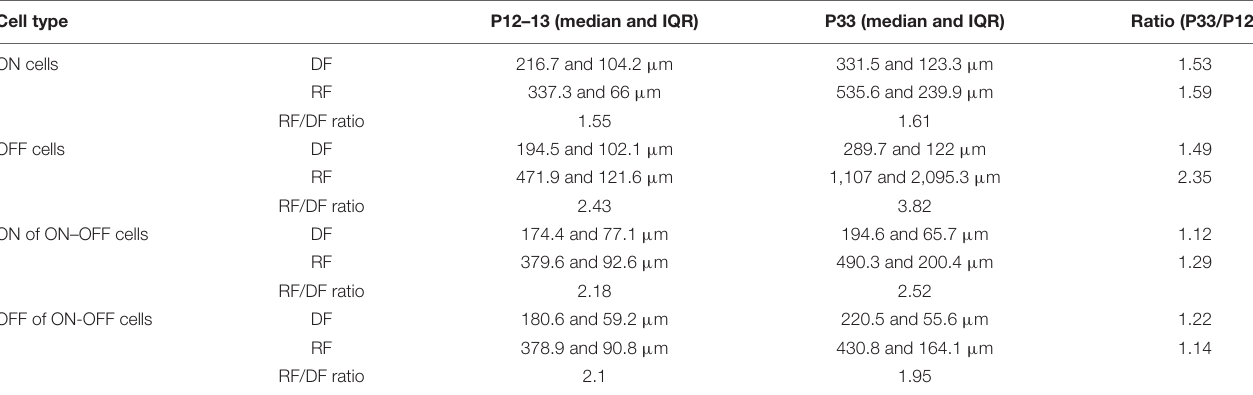
TABLE 1 | Size of dendritic field and receptive field of retinal ganglion cells (RGCs) at P12/13 and P33. Cell type P12–13 (median and IQR) ON